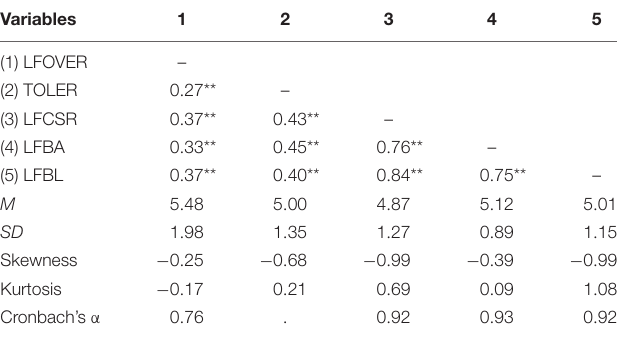
TABLE 4 | Bivariate relationships for least favorite league.